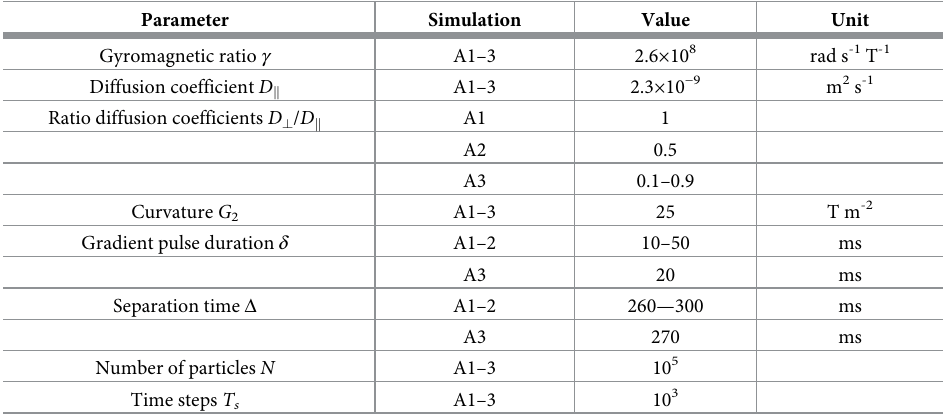
Table 1. The simulation parameters used in the validation simulations.